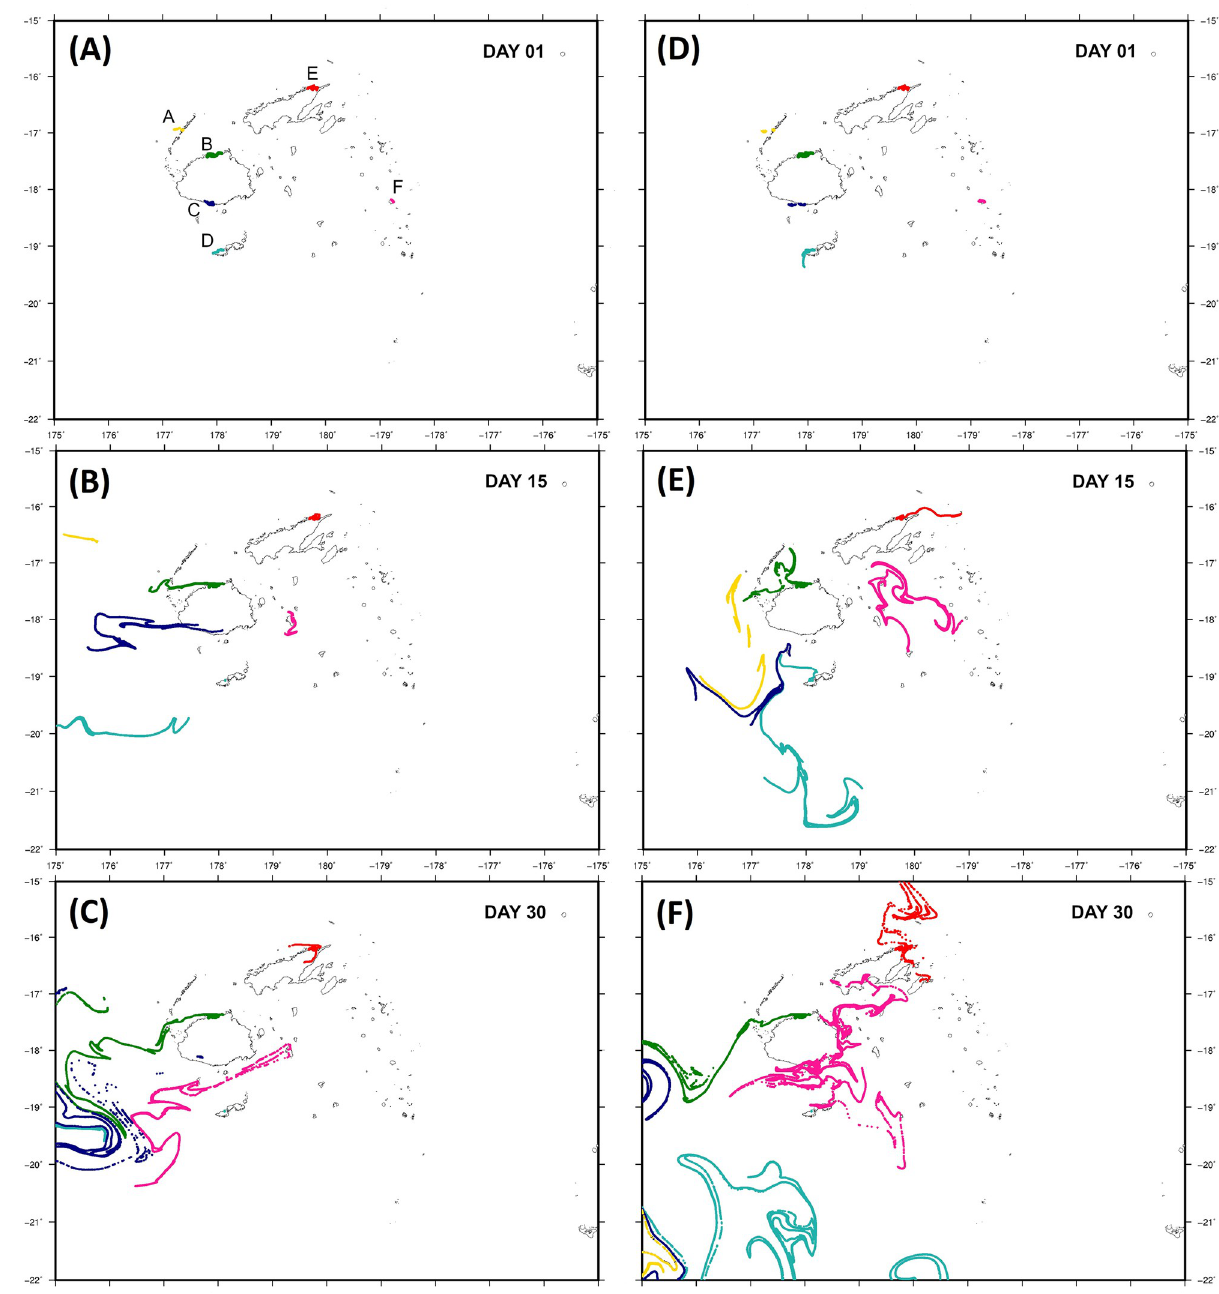
Fig 4. Particle dispersal simulation results for a La Ni ñ a (2012: A-C) and El Ni ñ o (2014: D-F) HYCOM datasets. Dispersal simulation progressions are shown for days 1, 15 and 30 for each year respectively. Animations of these simulations are available in S1 and S2 Figs. Base maps for dispersal visualization are adapted from Lal et al. [22]. Letters denote the following sampling locations: LA, Lakeba island, Lau archipelago; YA, Nacula island, Yasawa archipelago; SA, Serua island, Serua Province, Viti Levu; MA, Namuka district, Macuata Province, Vanua Levu; KA, Tavuki district, Kadavu, and RA, Raviravi district, Ra